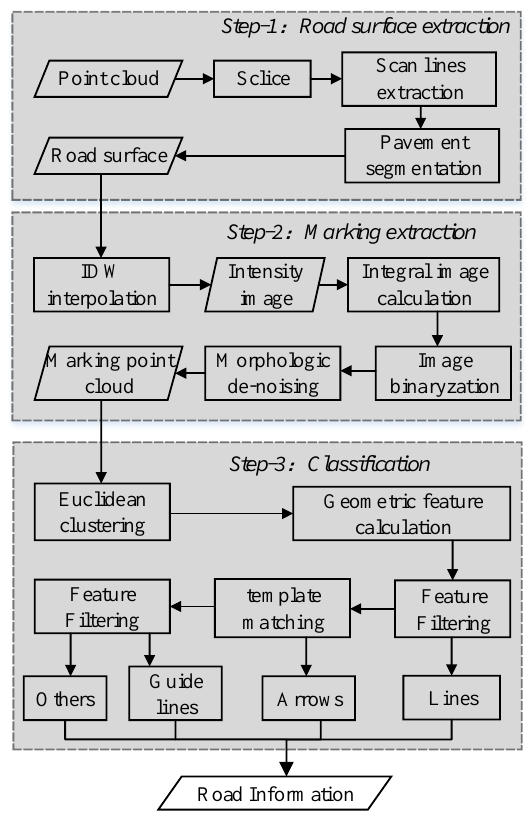
Figure 1. Flowchart of proposed